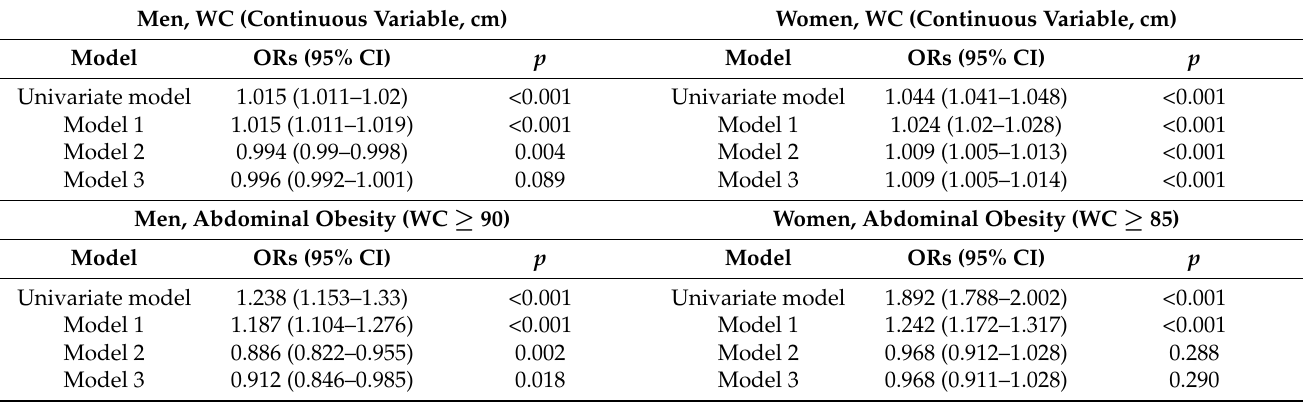
Table 2. Association between abdominal obesity and the risk of stroke identified by logistic regression.